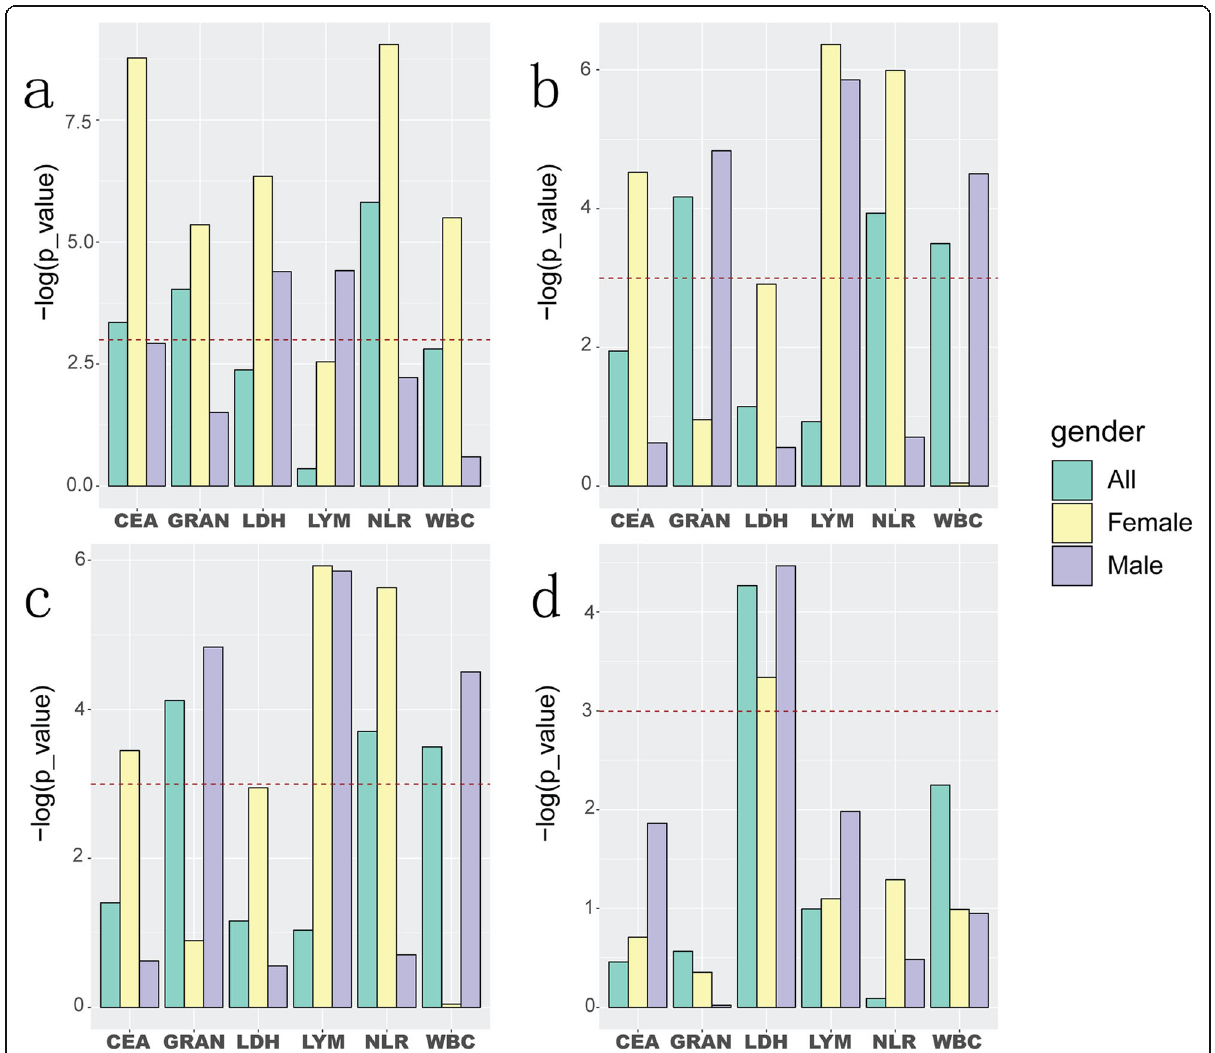
Fig. 5 Association between SNPs and six indicators. a rs2227981; b rs2227982; c rs36084323; d rs7421861. The dotted red line indicates the significance threshold ( p _value = 0.05)